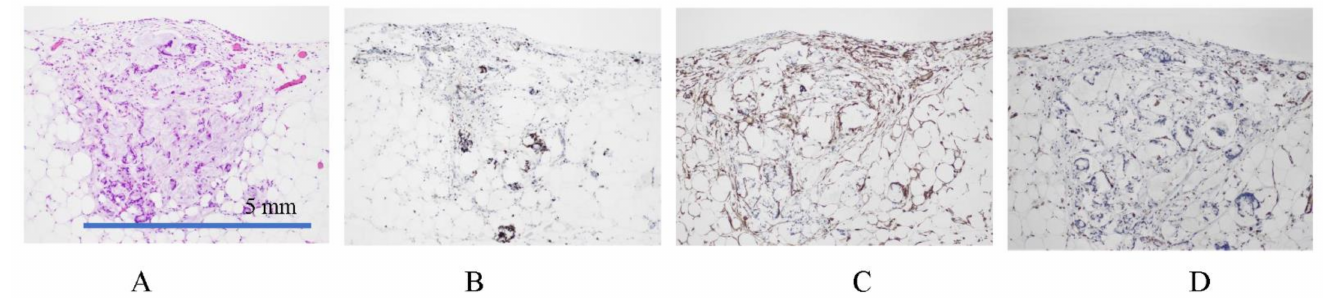
Figure 17. ( A ) An established metastasis of differentiated adenocarcinoma growing on the small bowel mesentery (HE staining). Stromal induction is already found. ( B ) Ki67 positive immunoreac- tivity in cancer cells. ( C ) CD34 immunoreactivity is found in the stroma of metastasis. ( D ) Newly formed blood vessels are found in the stroma (CD31 immunostaining).